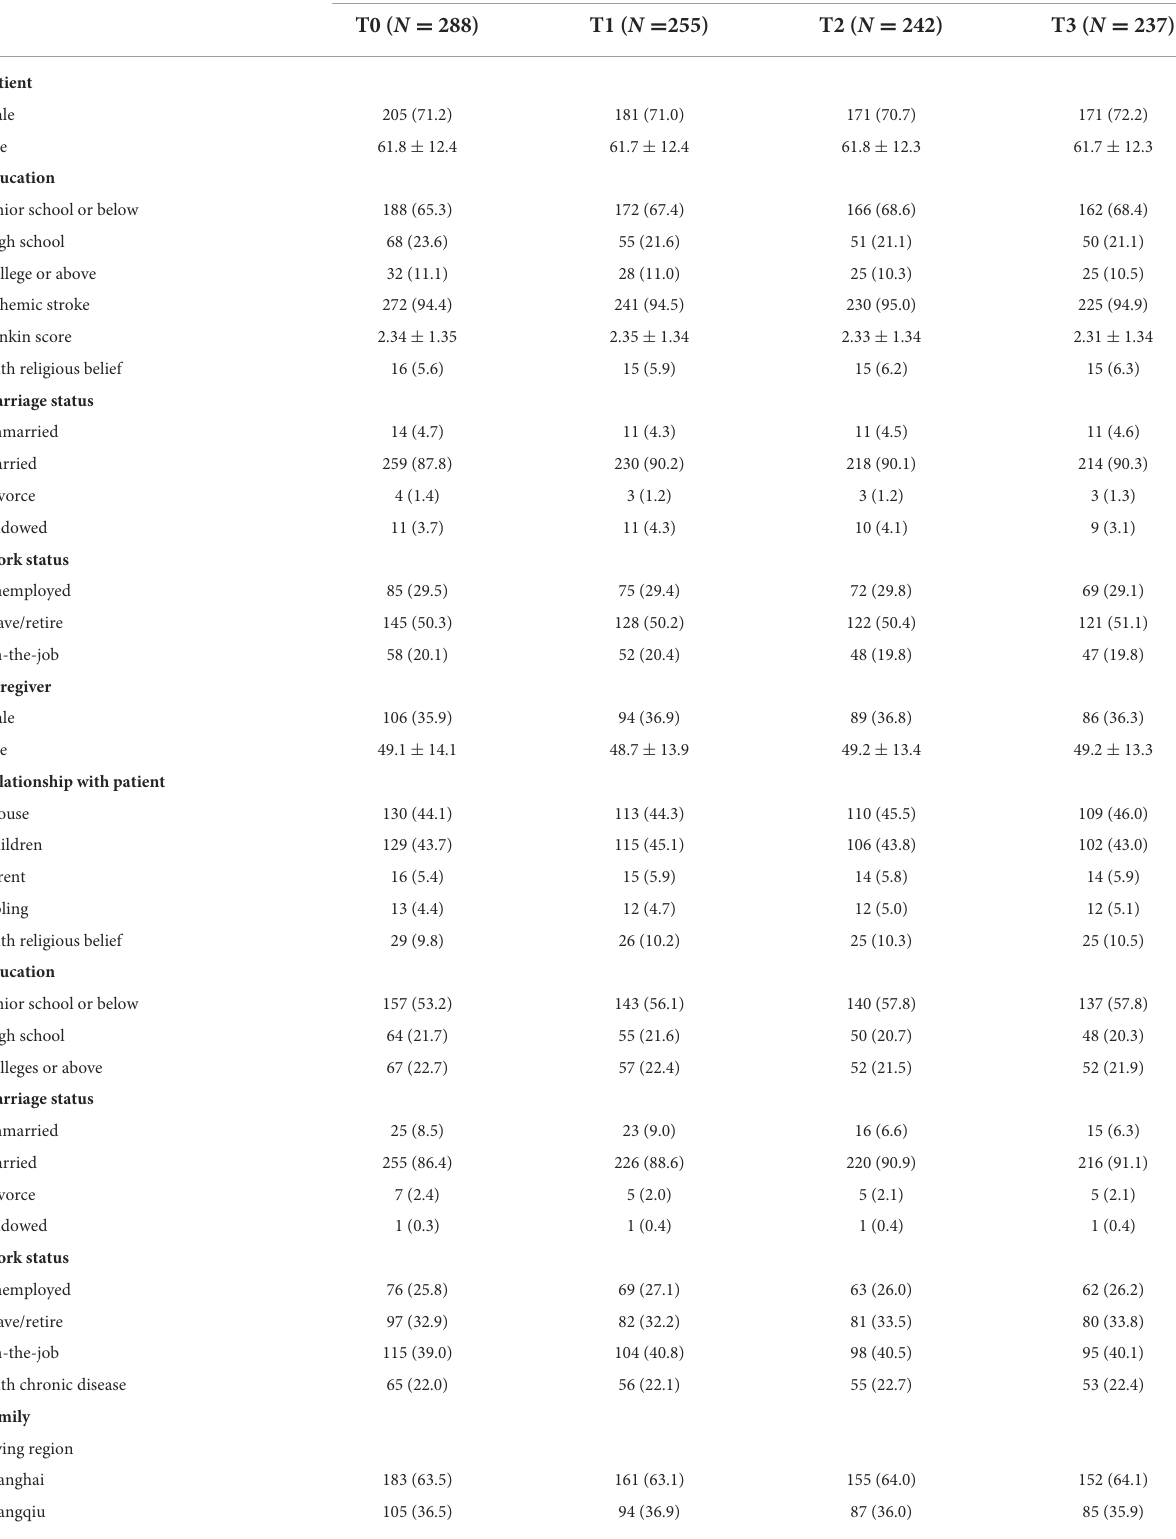
TABLE 1 Characteristics of participants at baseline, 1, 3, and 6 months after stroke